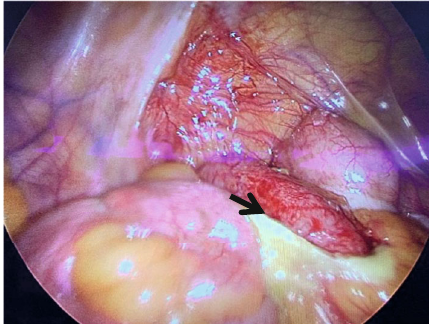
Figure 2: Intraoperative fi ndings showing acutely in fl amed appendix with fi brinous